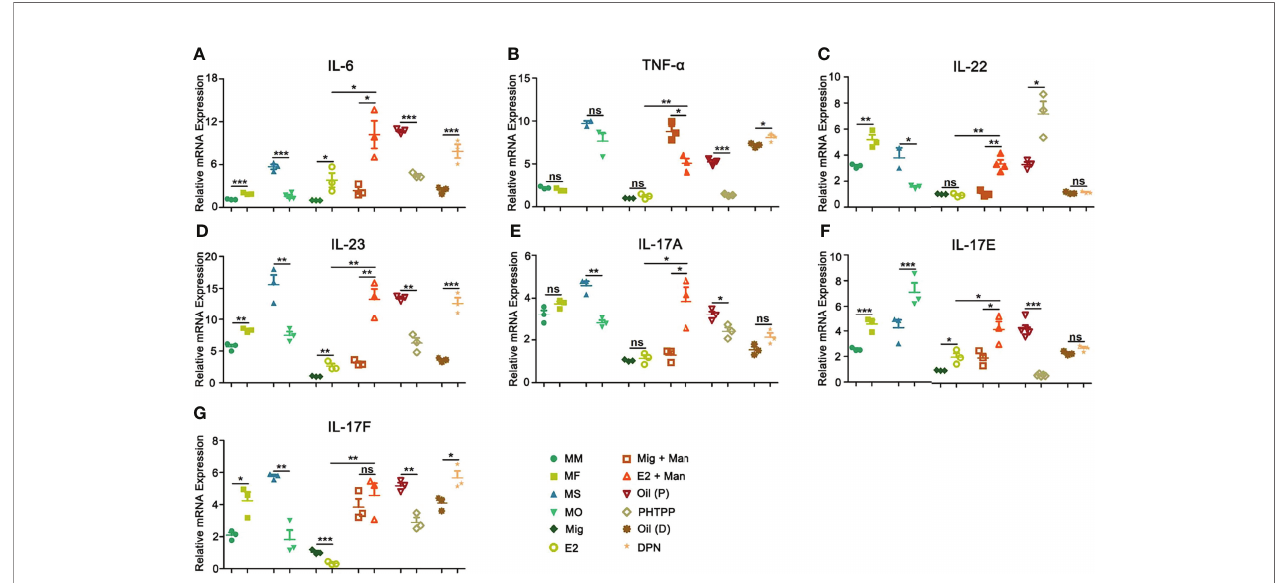
FIGURE 9 | Estrogen promoted psoriasis symptoms were dependent on IL23/IL-17 axis. Expression of (A) IL-6, (B) TNF- a , (C) IL-22, (D) IL-23, (E) IL-17A, (F) IL- 17E, and (G) IL-17F cytokines in male, female, OVX and sham operated, E2 or miglyol, PHTPP or DPN treated mice with and without mannan stimulation (n = 5/ group). Man, mannan; MM, Man + Male; MF, Man + Female; MO, Man + OVX; MS, Man + Sham; Mig, miglyol; E2, 17- b -estradiol; Oil (P), E2 + Corn oil + Man; PHTPP, E2 + PHTPP +Man; Oil (D), Corn oil + Man; DPN, DPN + Man. Statistical analyses were performed using an unpaired t test and n indicates number of mice. The data represent mean ± SEM. ns, not signi fi cant. *p < 0.05; **p < 0.01. ***p <